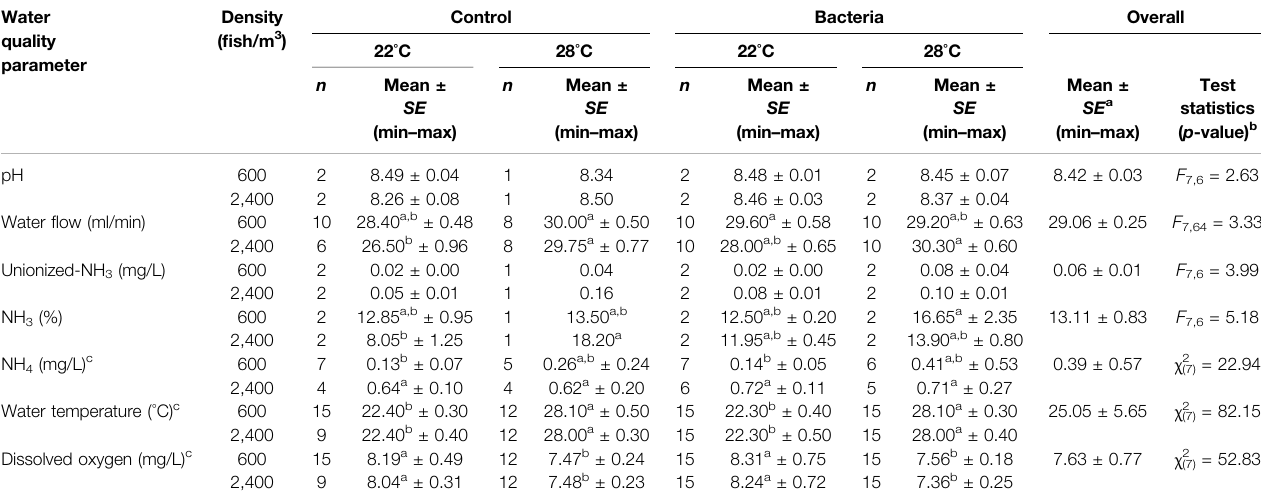
TABLE 1| Water quality [number of measurements ( n ),mean, standard error ofthe mean ( SE ),minimum measurement(min),and maximum measurement (max)] measured in tanks of eight treatments. Golden Shiners were subjected to low (600 fi sh/m 3 ) or high (2,400 fi sh/m 3 ) densities at low (22 ° C) or high (28 ° C) temperature treatments. Treatments included challenge with F. covae (Bacteria) or no exposure to F. covae (Control). Based on normality testing, tests used were either analysis of variance (test statistics =